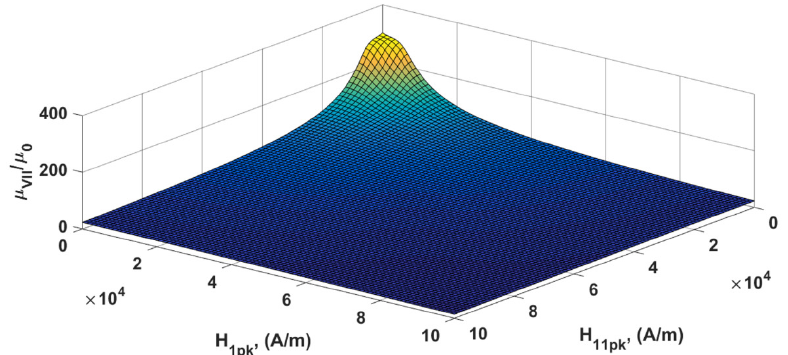
Figure 5. Relative multidimensional effective permeability calculated for the DC magnetization curve of the rotor, assuming zero value of the magnetic field strength of the thirteenth harmonic. Table 3. Averages percent value of the relative error for N = 11 considered points of the curves.